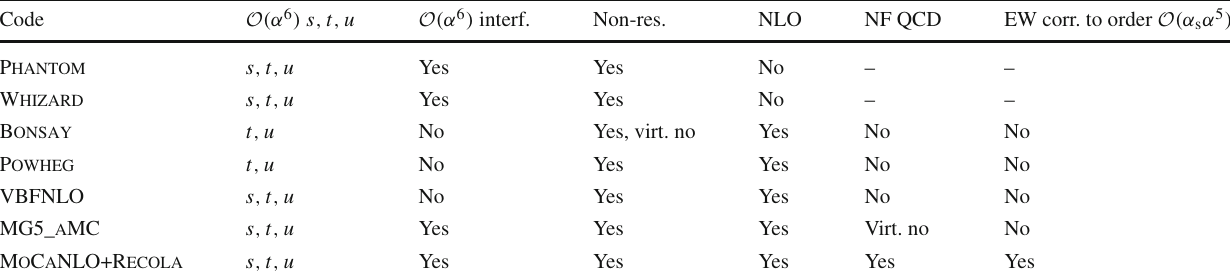
Table 1 Summary of the different properties of the computer programs employed in the comparison Code O (α 6 ) s , t , u O (α 6 ) interf.